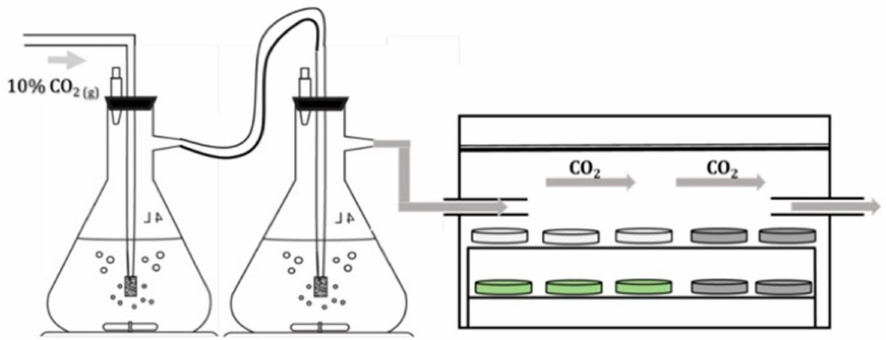
Figure 3. Schematic of the disk carbonation reaction chamber. Colored disks represent the various solid tailings samples molded into disks. Figure adapted with permission from